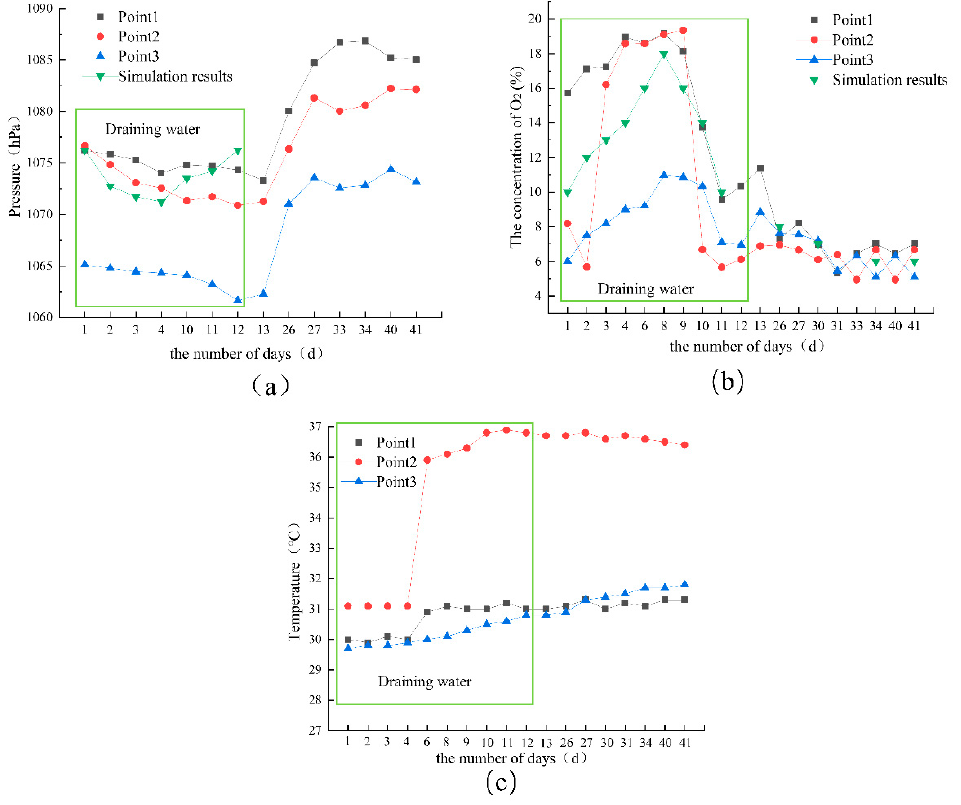
Figure 10. Variations of internal parameters in the goaf drainage process. ( a ) pressure variation, ( b ) Change in oxygen concentration, ( c ) temperature variation.